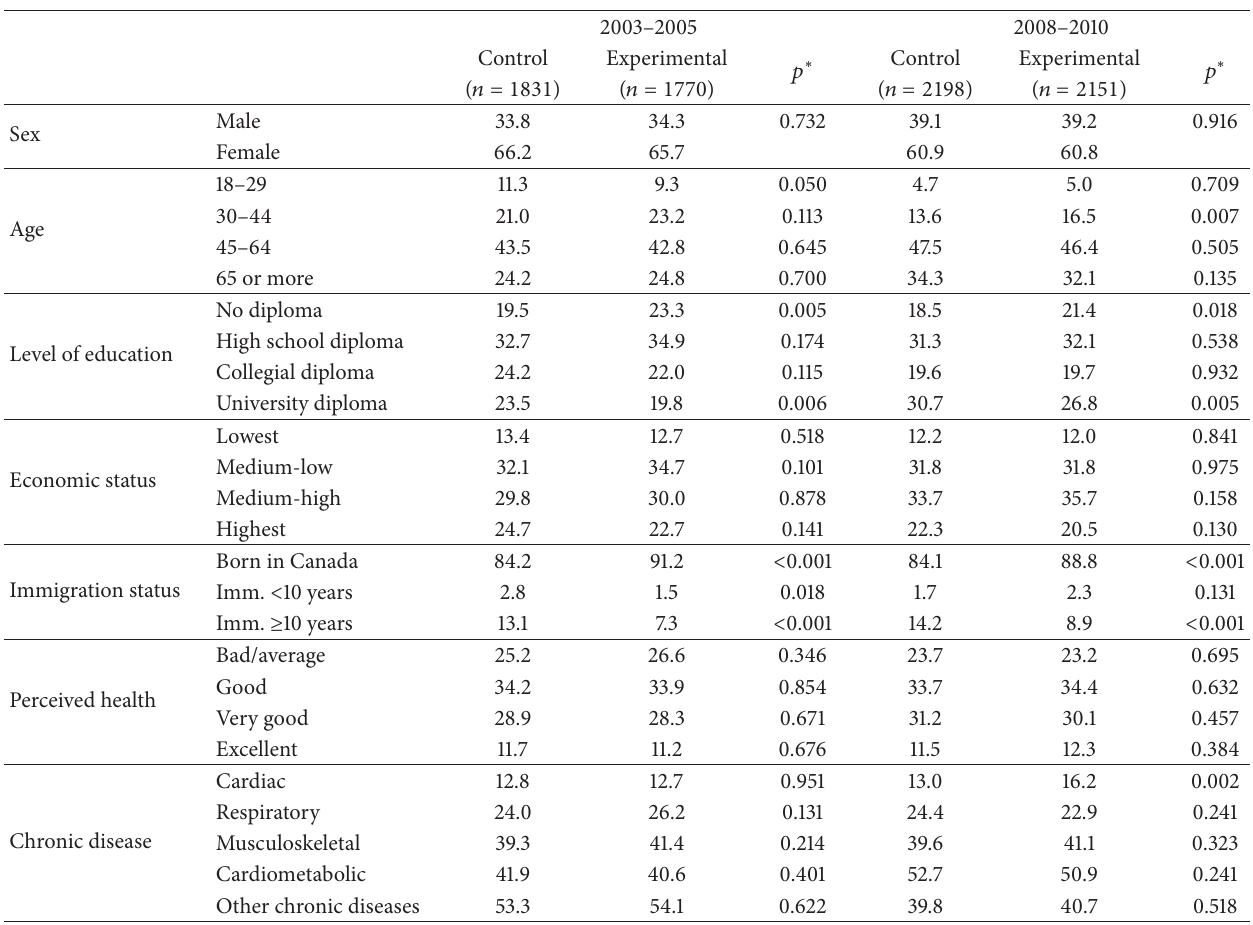
∗ Difference of proportions